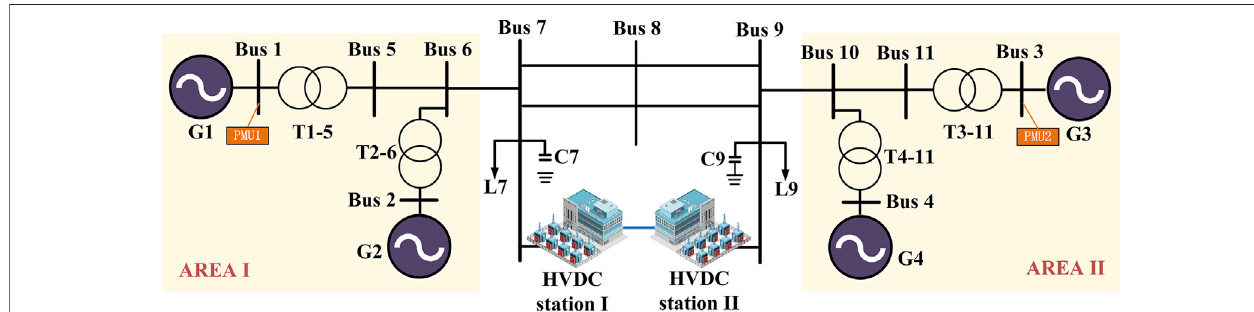
FIGURE 7 | Diagram of the two-area four-machine system. Scenario I: Partial Dataset Training.